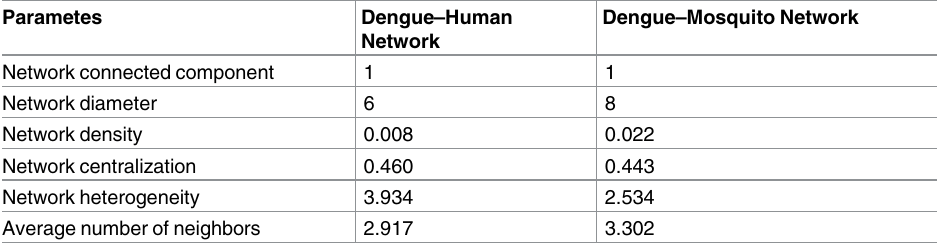
Table 1. Comparative statistical analysis of dengue–human and dengue–mosquito PPI network.